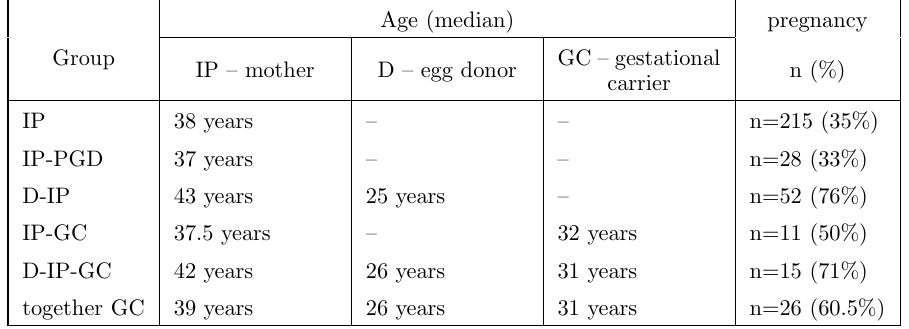
Table 2. Age and percentage of pregnancy in compared groups Age